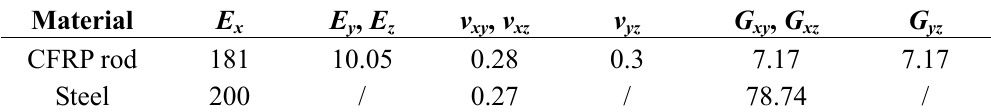
Table 1. Material properties (GPa).